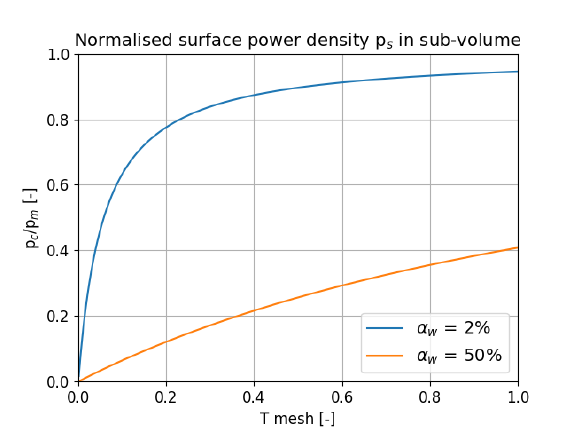
Figure 6. Insertion loss of wire meshes using the caloric load. MISTRAL not at vacuum: to avoid possible arcing the calibra- tion pulse (blue) was limited to one